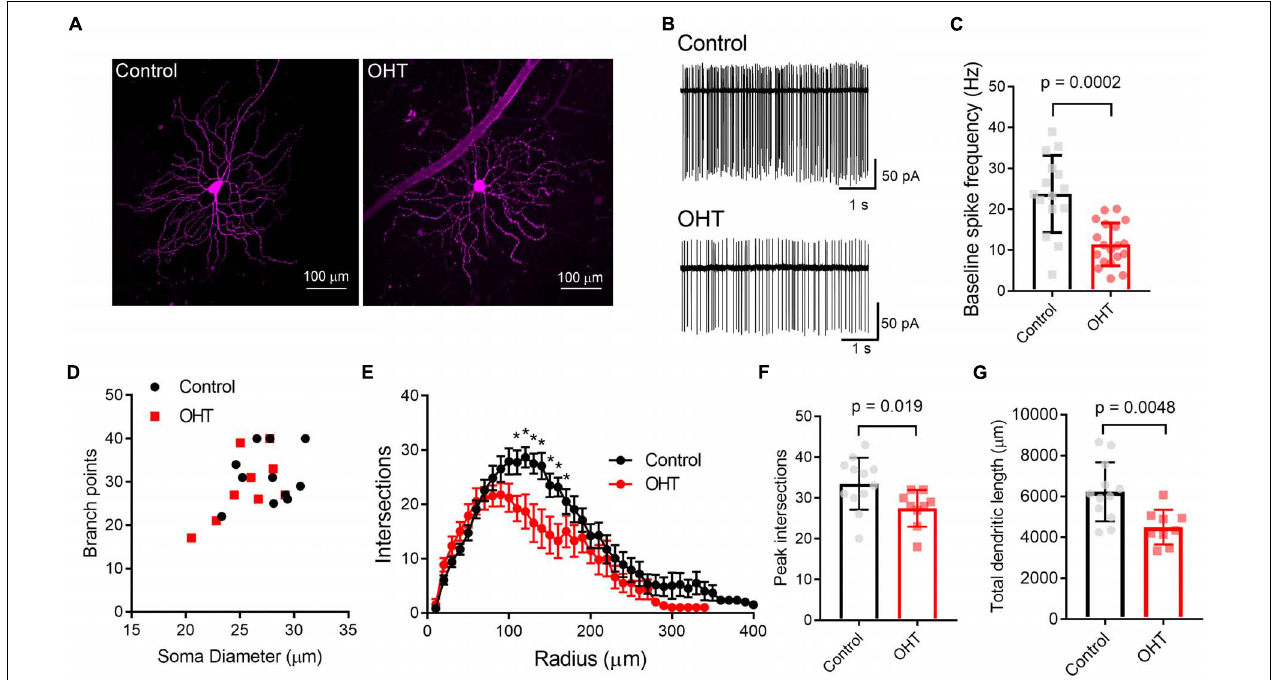
FIGURE 2 | Ocular hypertension alters the structure and function of M4-type RGCs. (A) Maximum intensity projection images of dye-filled M4/On- α RGCs filled with CF568 dye during whole cell recording in flat mount retinas. (B,C) In cell-attached measurements of spontaneous spiking (in the dark, in the absence of stimulus), the spontaneous spike frequency was lower in OHT than control. (D) Plot of soma size and number of dendritic branch points for filled RGCs. Control and OHT populations overlapped and resembled previous reports of parameters for M4 melanopsin-expressing RGCs. (E) Sholl analysis of M4 dendrites shows that dendritic complexity was slightly reduced relative to control cells. (F) Comparison of peak number of Sholl intersections in control and OHT M4 RGCs. (G) Total dendritic length was reduced in M4 RGCs from OHT retinas. Values for each cell are plotted individually in (C,F,G) and the bar graphs represent mean + standard deviation. ∗ p <